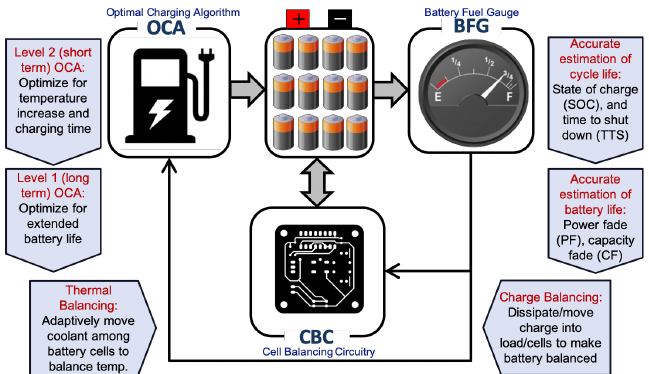
Figure 4. Functional block diagram of a battery management system. Three important components of a BMS are battery fuel gauge, optimal charging algorithm and cell balancing